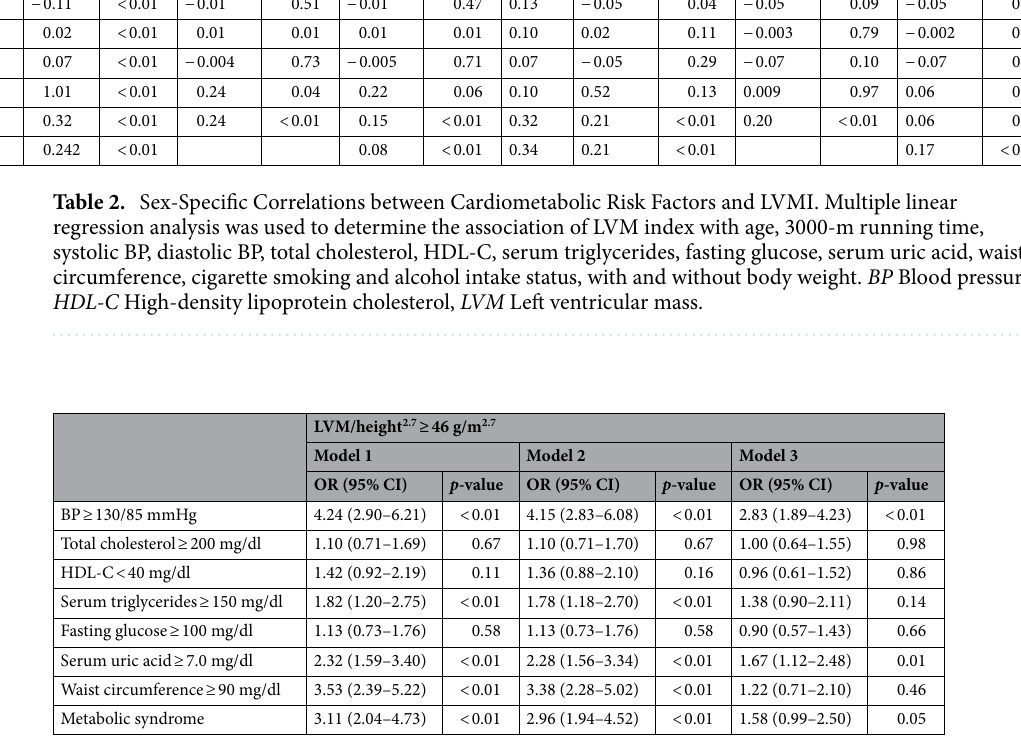
Table 3. Associations between Cardiometabolic Risk Factors and Echocardiographic Left Ventricular Hypertrophy in Men. Multiple logistic regressions were used to determine the association of cardiometabolic risk factors with echocardiographic left ventricular hypertrophy. Model 1 adjusted for age, BP ≥ 130/85 mmHg, total cholesterol ≥ 200 mg/dl, HDL-C < 40 mg/dl, serum triglycerides ≥ 150 mg/dl, fasting glucose ≥ 100 mg/ dl, serum uric acid ≥ 7.0 mg/dl, waist circumference ≥ 90 mg/dl, metabolic syndrome status, cigarette smoking status and alcohol intake status. Model 2 adjusted for the covariates in model 1 and 3000-m running time. Model 3 adjusted for the covariates in model 2 and body weight. BP Blood pressure, HDL-C High-density lipoprotein cholesterol, LVM Left ventricular